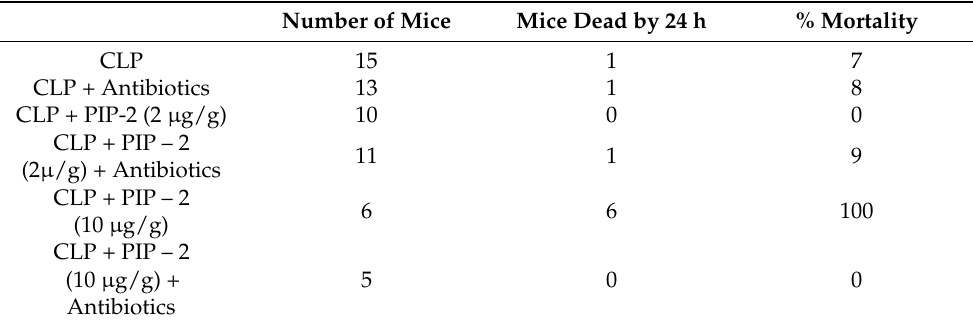
Table 2. Mortality within 24 h after